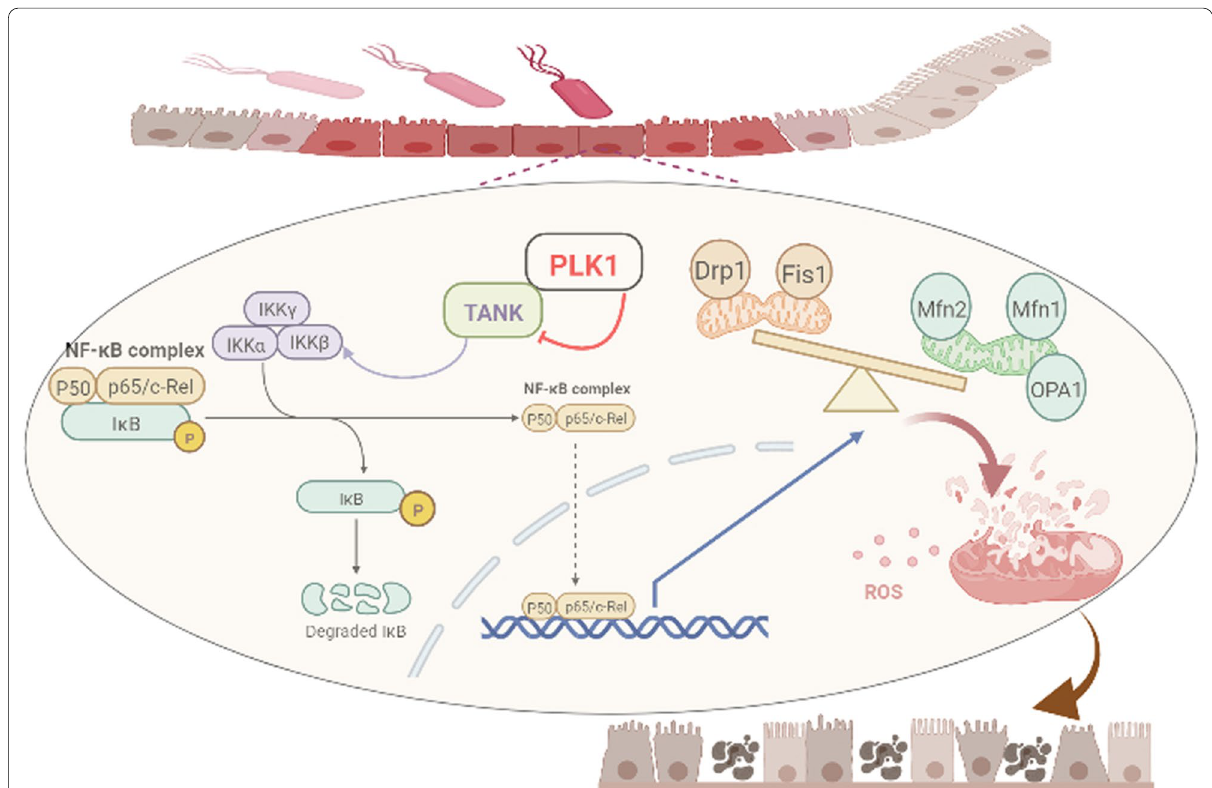
Fig. 8 Schematic showing the regulatory mechanism of PLK1/TANK/NF‑κB signalling in sepsis‑induced intestinal barrier dysfunction. Sepsis/LPS downregulates PLK1 expression in the intestinal epithelium, weakening the inhibitory effect of PLK1 on TANK and increasing TANK expression, which subsequently activates NF‑κB signalling. Activated NF‑κB disrupts the balance in mitochondrial dynamics, destroys mitochondrial function through increased ROS production, induces apoptosis in the intestinal epithelium and ultimately leads to intestinal barrier